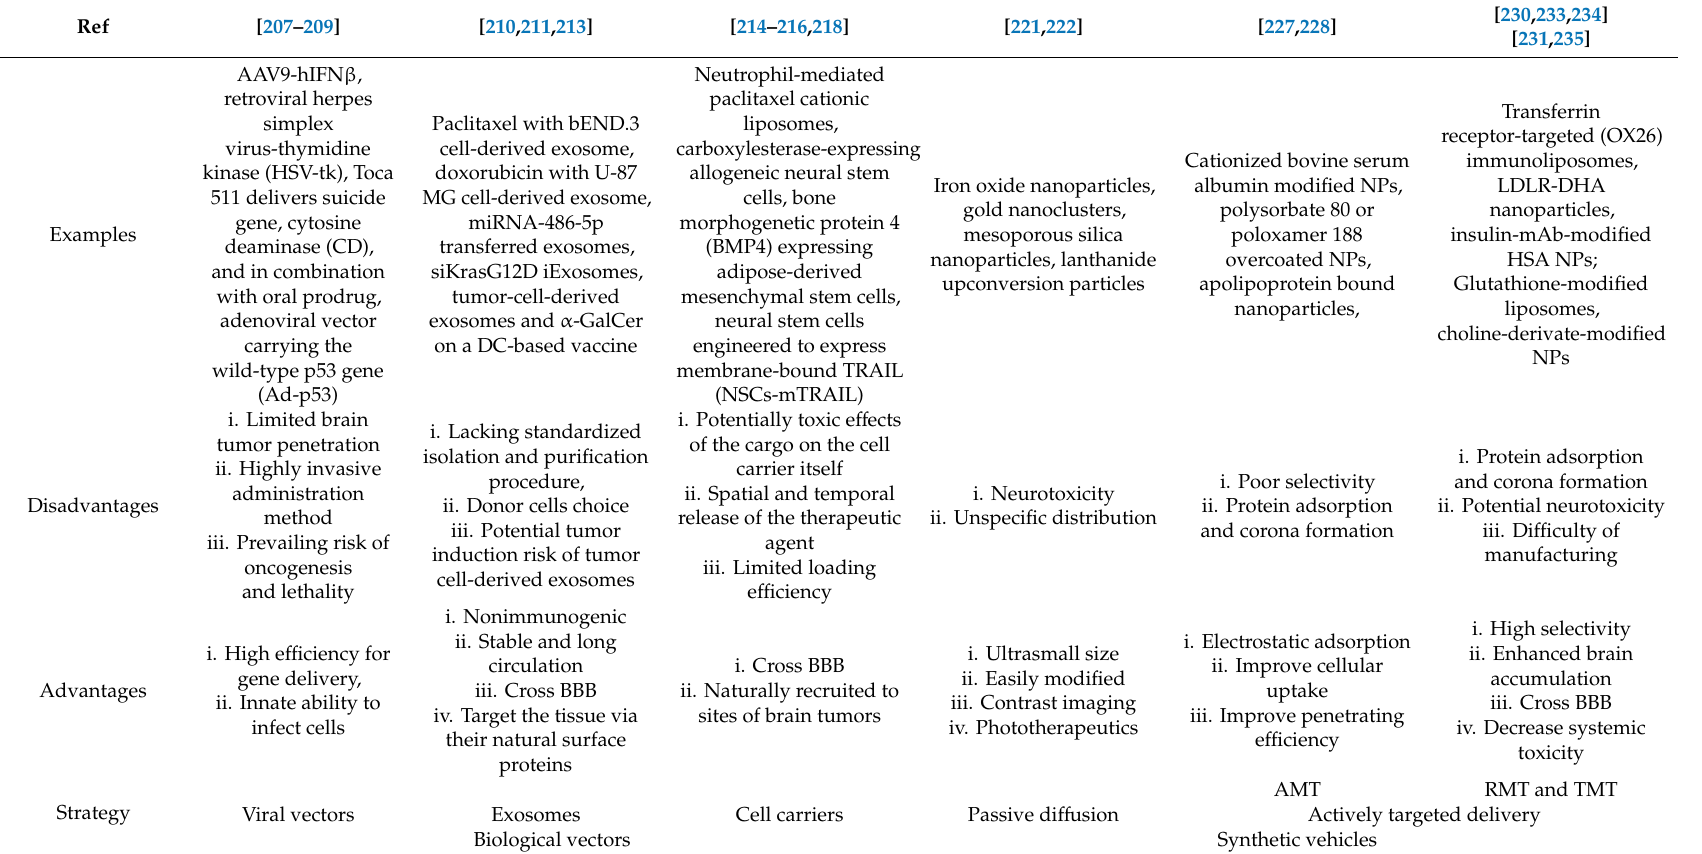
Table 4. Nanoparticles for brain drug